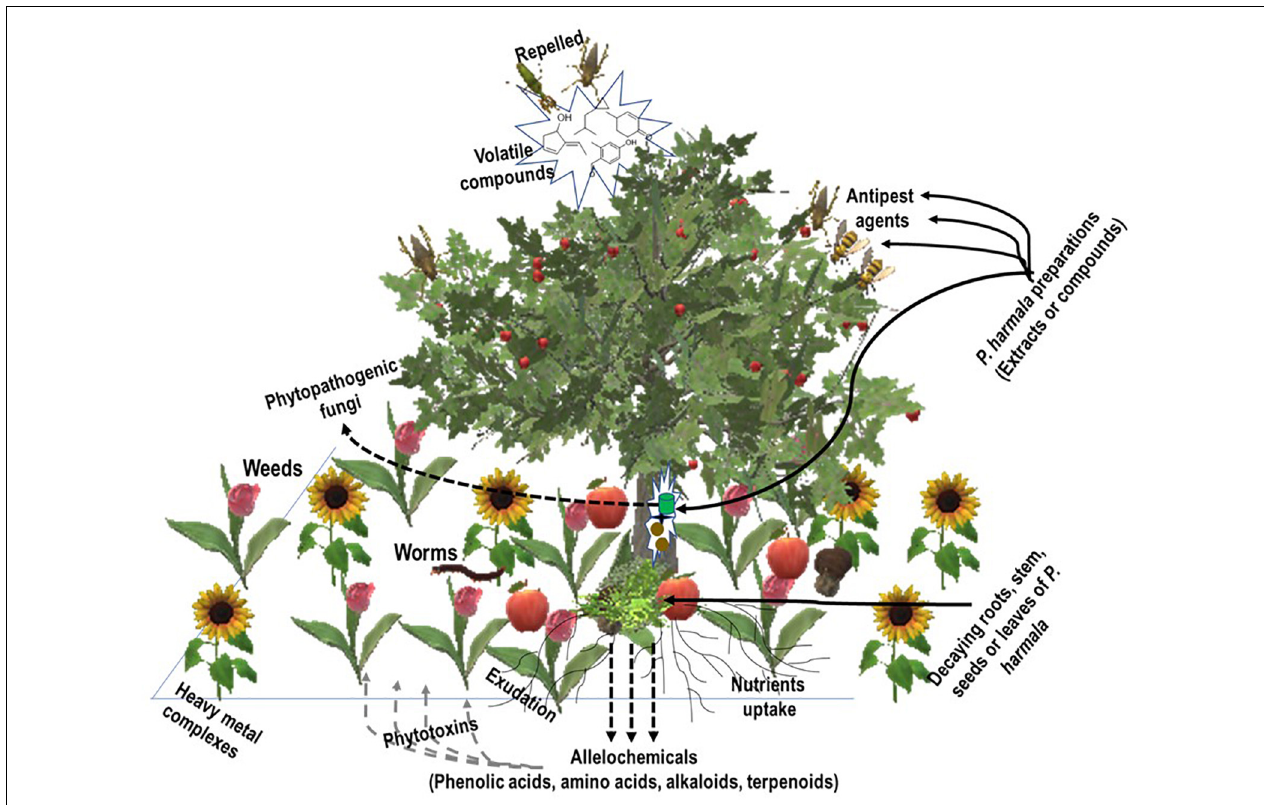
FIGURE 2 | Crops in the rhizosphere. Crops expel pests by releasing volatile and aromatic compounds while exuding (alongside weeds) some chemicals into the soil. Amended soil with mulches of the allelopathy plant enriches it with alkaloids, phenolic compounds, and terpenes, which also constitute phytotoxins for weeds. Preparations of the allelopathy plant ( P. harmala ), extracts, or compounds constitute anti-pest and antipathogenic fungi agents to protect the